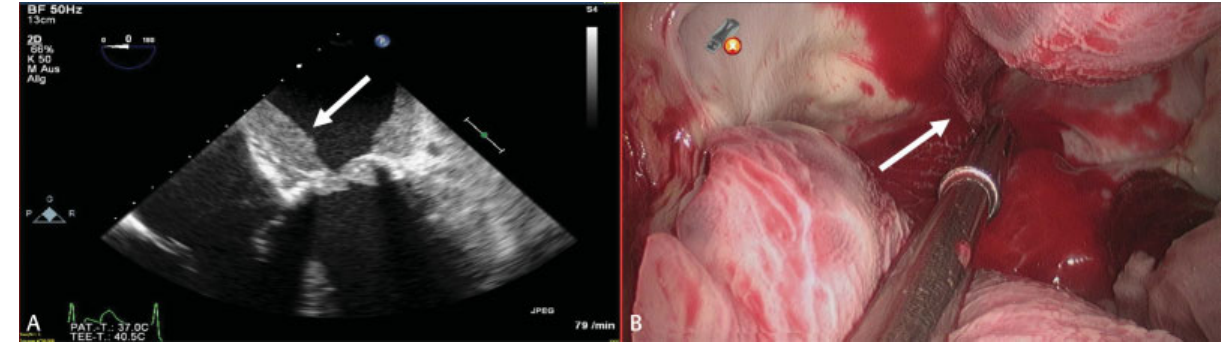
Fig. 3 ( A ) Massive thrombus formation ( arrow ) in the left atrium in transesophageal echocardiographic view. ( B ) Intraoperative view of thrombus sticking to imprints of lines ( arrow ) drawn with the cryoablation probe in the left